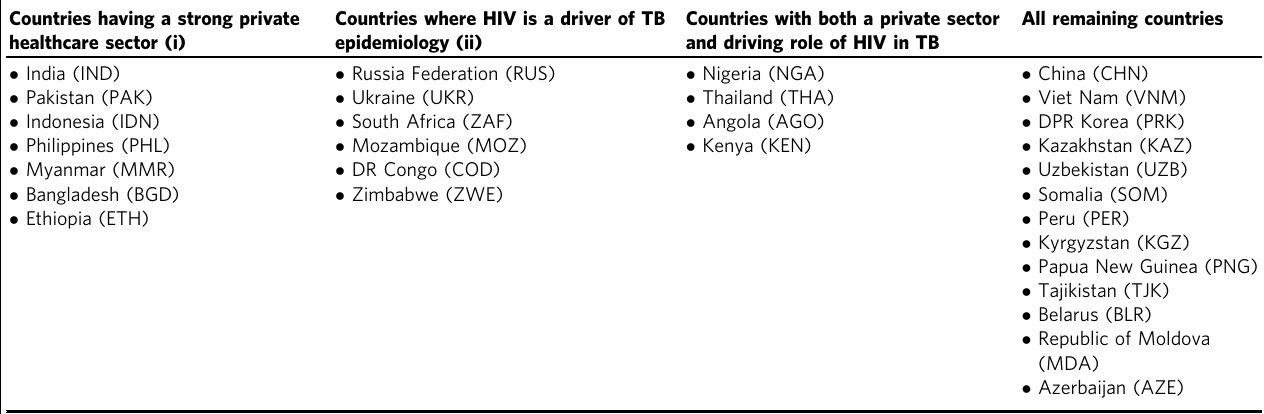
Countries where HIV is a driver of TB epidemiology (ii) (cid:129) Russia Federation (RUS) (cid:129) Ukraine (UKR) (cid:129) South Africa (ZAF) (cid:129) Mozambique (MOZ) (cid:129) DR Congo (COD) (cid:129) Zimbabwe (ZWE)